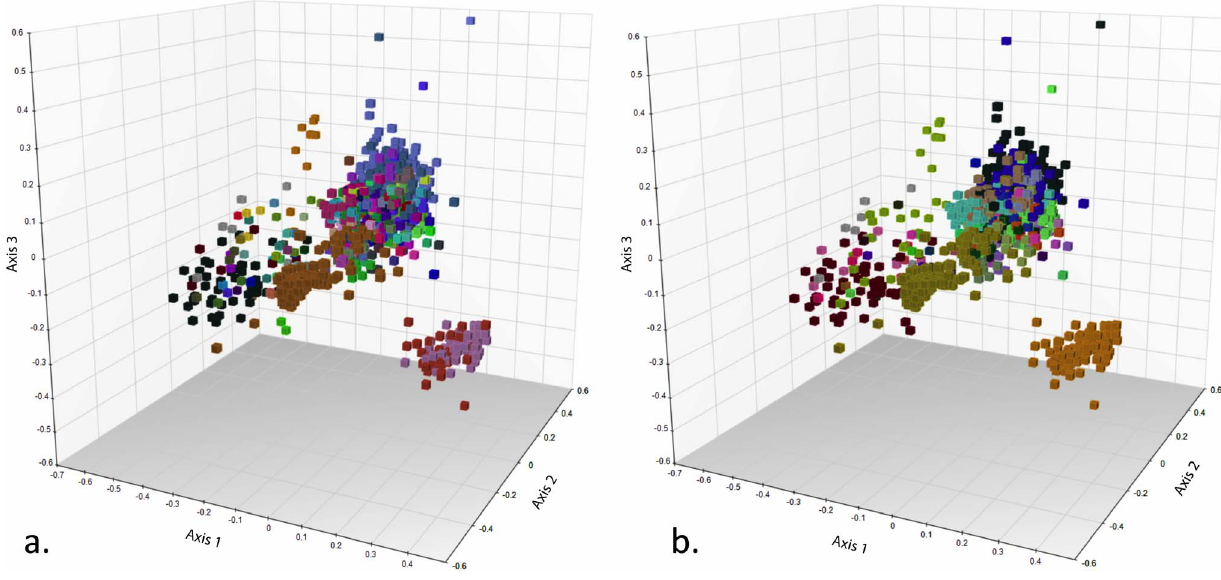
Figure 3. Assessment of concordance between taxonomic (herbarium determination) and DNA similarity assignment using nonmetric multidimensional scaling (NMDS) ordination of the pairwise genetic distance matrix. a. Data symbols coded by genus. b. Data symbols coded by family.